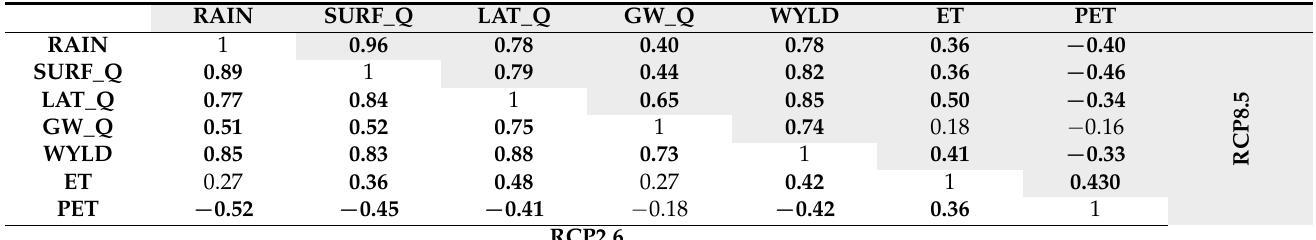
Table 11. Correlation coefficients for the relationship between monthly projected precipitation change and monthly projected water budget component